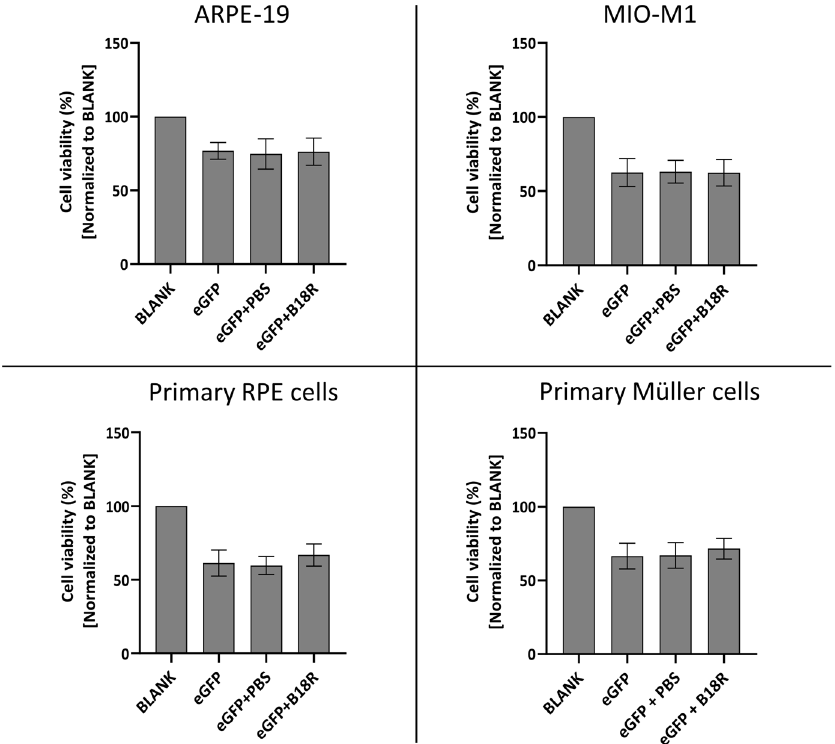
Figure 7. Cell viability following transfection with mRNA-MessengerMAX lipoplexes with or without co-treatment with B18R as determined by the MTT-assay. Read-out was performed 24 h after mRNA transfection. Data are expressed as the relative cell viability normalized to the untreated control group (BLANK) which did not receive any treatment. (n = 3 × 3).